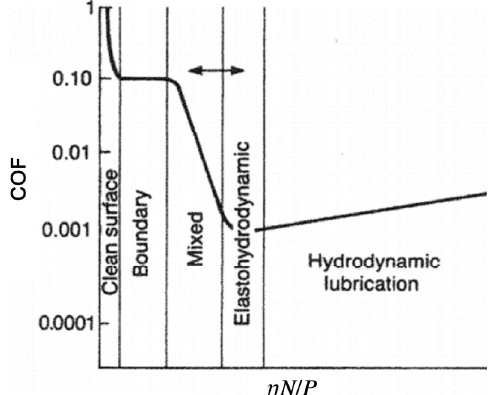
Fig. 1 Characteristic and friction regimes of the Stribeck curve. Reproduced with permission from Ref. [1], © John Wiley & Sons, Ltd